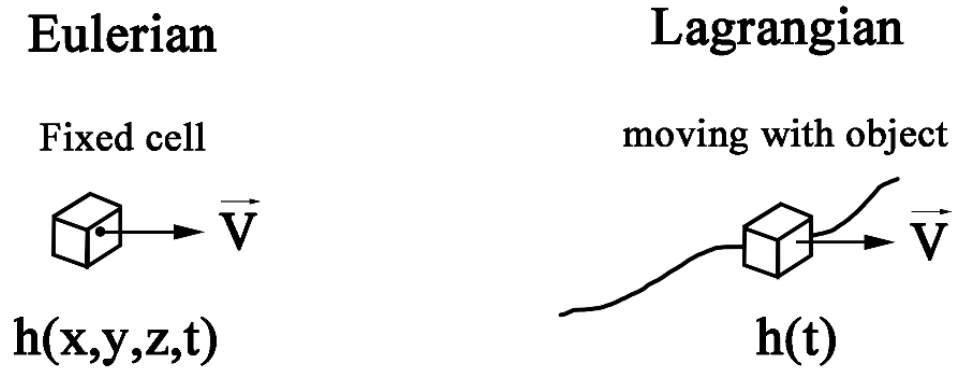
Figure 2. Eulerian and Lagrangian descriptions.